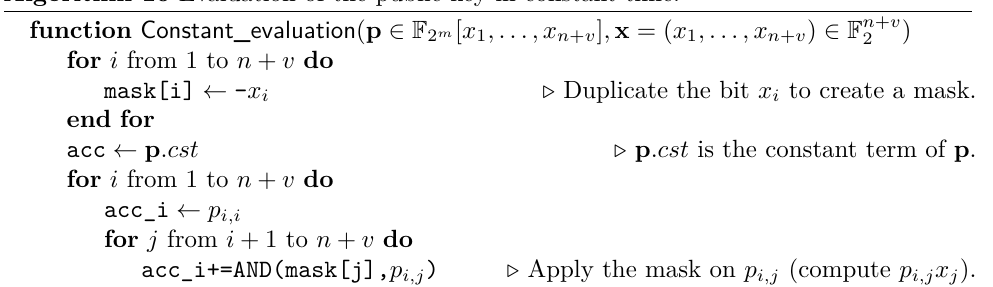
Algorithm 10 Evaluation of the public-key in